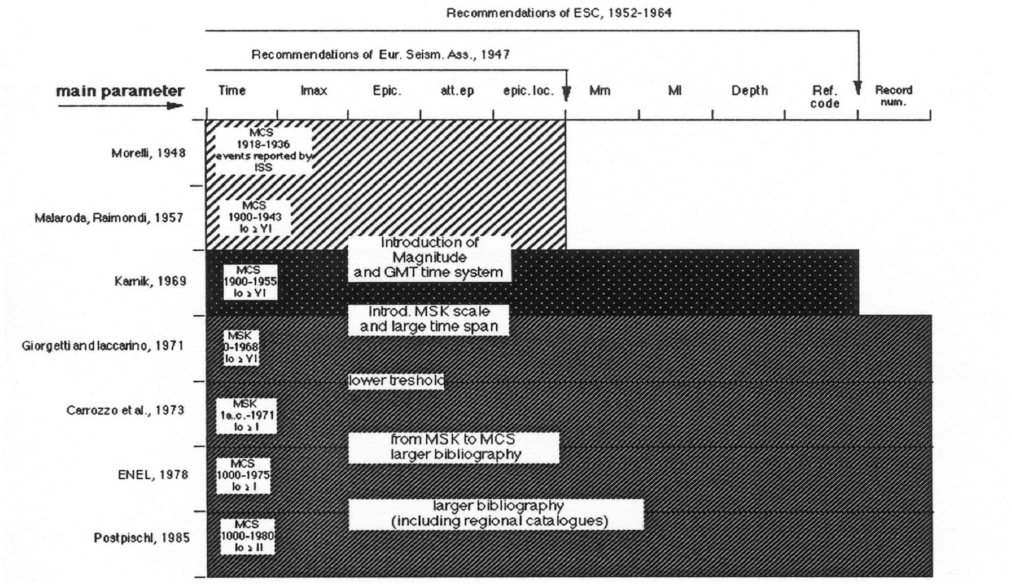
Fig. 2. Main characteristics of Italian parametric earthquake catalogues from 1948 to 1985: the turning point is the publication of the Karník catalogue which introduced a magnitude parameter. The type of macroseismic scale used (MCS or MSK) is not clearly reported, so in the Postpischl catalogue it comes out